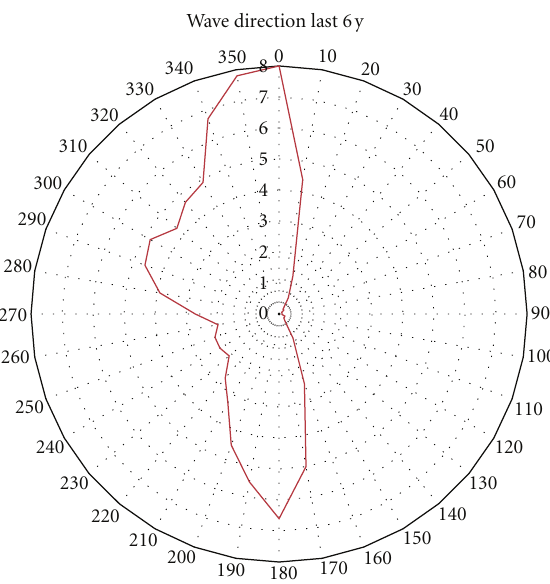
Figure 32: Relative frequency of occurrence of the wave direction 2004–2010 for the Troll A platform.